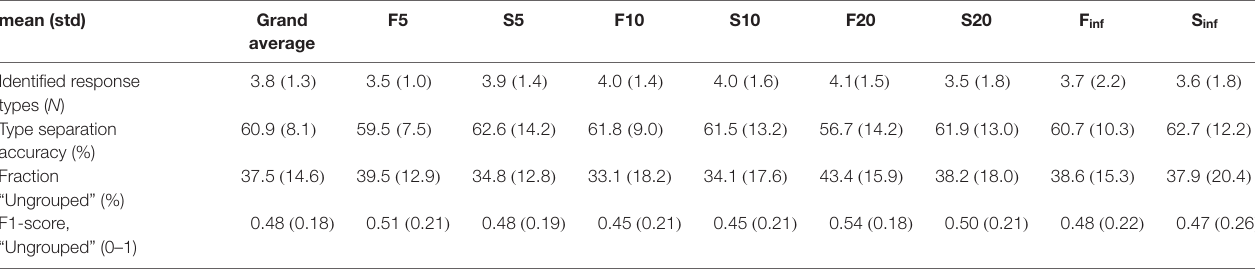
TABLE 1 | Number of response types and the performance measures for the response type separation for each stimulation pattern separately, based on principal component analysis (PCA) and k-nearest neighbors (kNN) analysis. mean (std) Grand F5 S5 F10 S10 F20 S20 F inf S inf